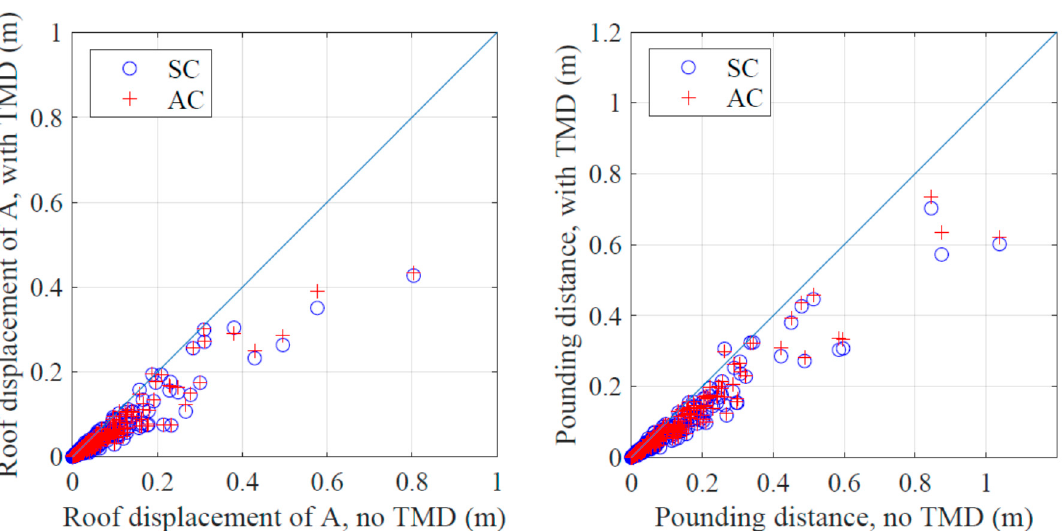
Figure 7. Roof displacement of building A ( left ) and minimum separation distance to avoid pounding ( right ) when subjected to 462 earthquake ground motions. The abscissa and ordinate correspond to uncontrolled and controlled structures, respectively.